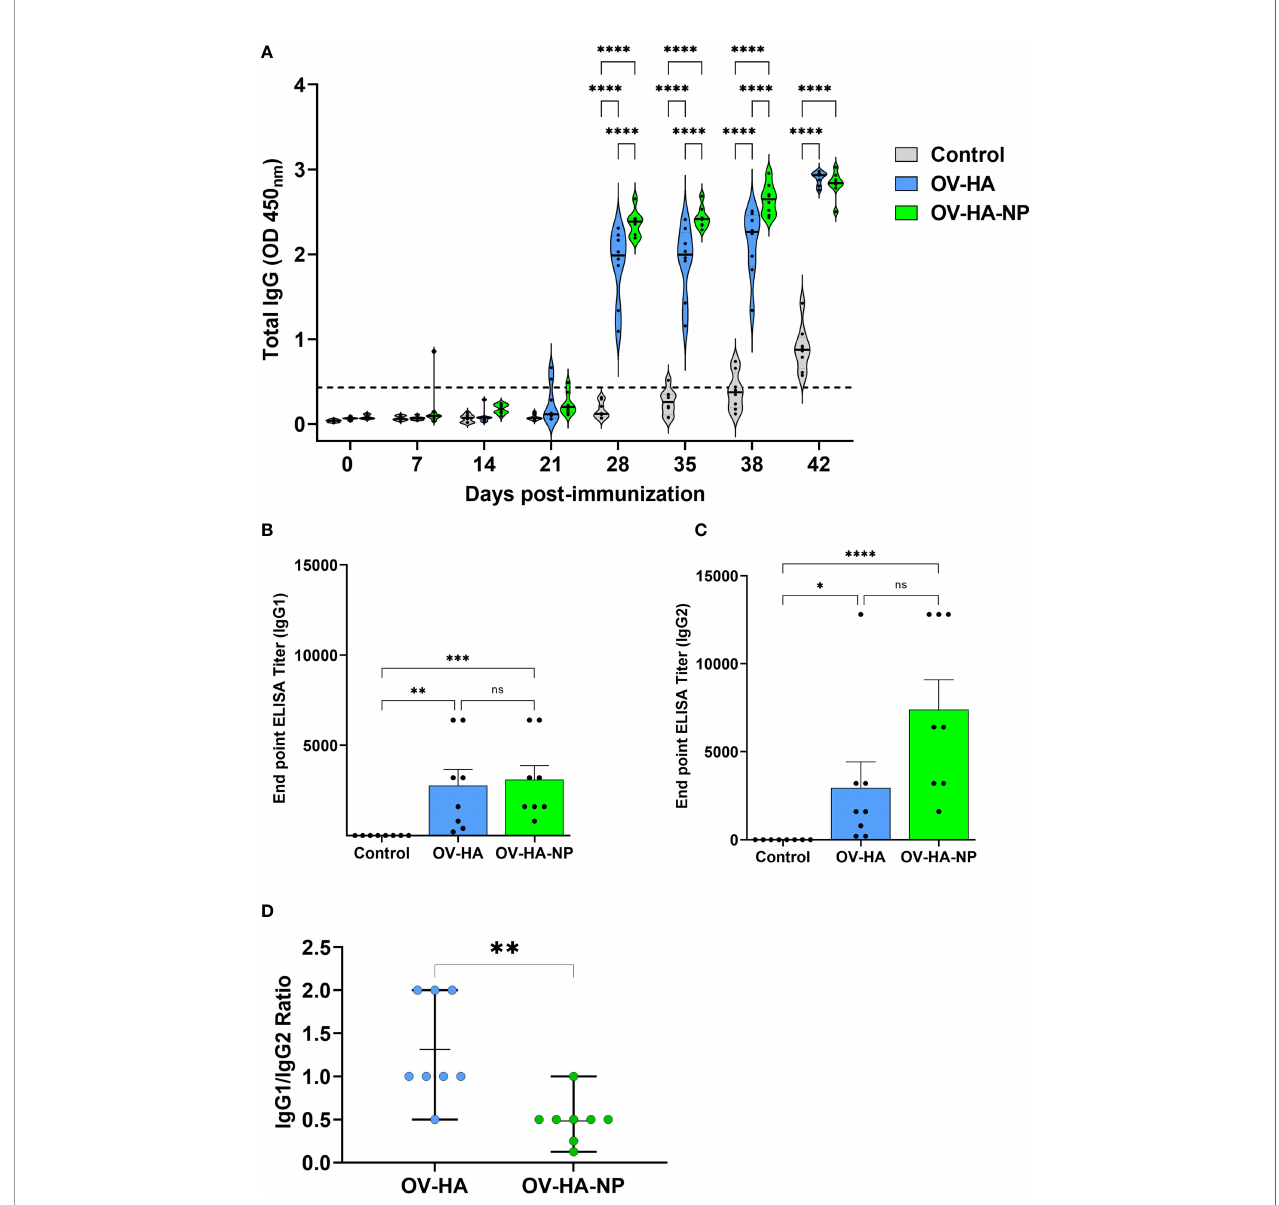
FIGURE 4 | IAV-S speci fi c IgG responses to immunization. (A) Total serum IgG level elicited by OV-HA and OV-HA-NP immunization at various time points were assessed by ELISA. Isotype ELISA demonstrating endpoint titers elicited by immunization at 35 days pi in serum was assessed for detecting speci fi c (B) IgG1 and (C) IgG2 antibodies. (D) IgG1/IgG2 ratio in immunized animals. Each dot represents IgG1/IgG2 ratio of an individual animal. Middle bar represents mean ratio and upper and lower bars represent range. P-values: *P < 0.05, **P < 0.01, ***P < 0.001, ****P < 0.0001; ns, non-signi fi